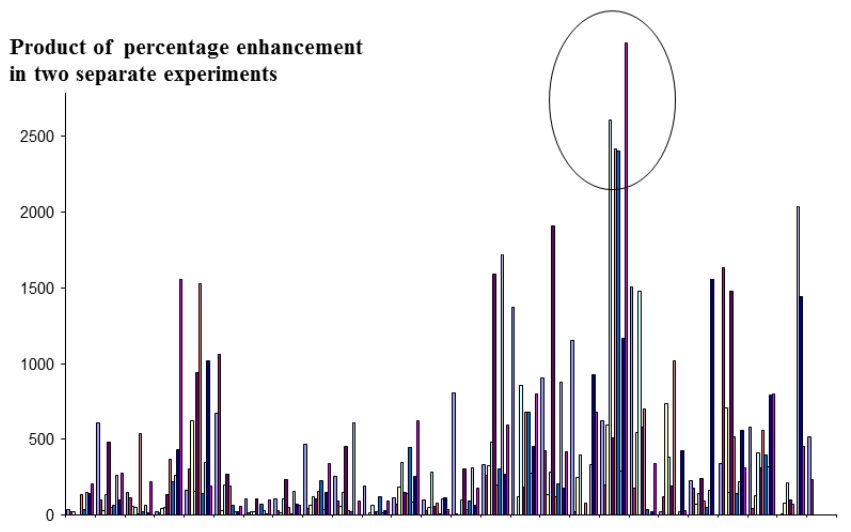
Figure 4. Detection of interactions between micelles and lysozyme using the FRET technique to screen each member of a [10/5] library against its conjugate